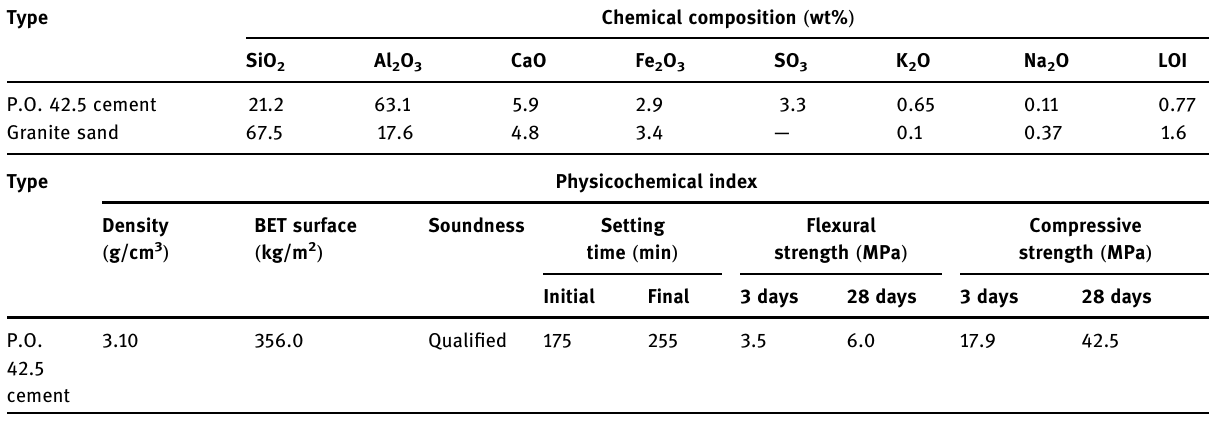
Table 1: Main physicochemical properties of ordinary Portland cement and granite mountain sand